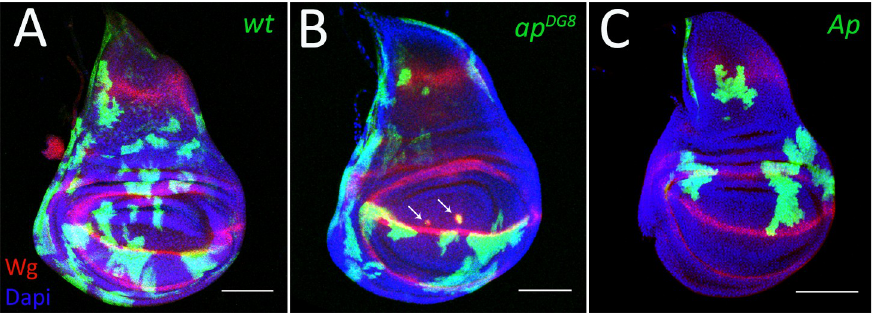
Fig 1. The recovery of clones altered for Ap function is compartment biased. (A-B) Third instar wing discs with GFP-marked wild-type (A), ap DG8 (B) and Ap-expressing (C) clones. The arrows point to ectopic Wg expression around mis-specified clones. Scale bars represent 100 μ m. Hereinafter disc orientation is dorsal up, anterior to the